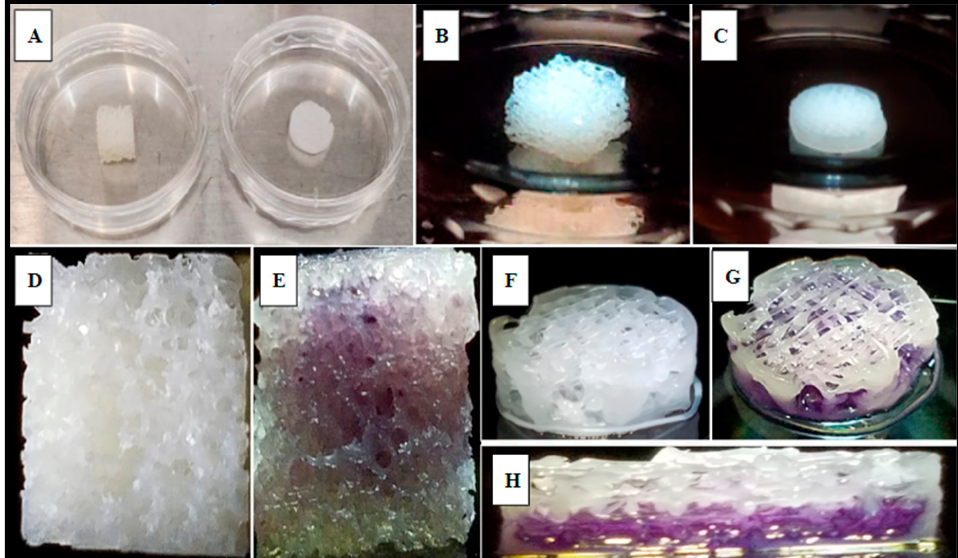
Figure 5. Gross examination of viable SAOS-2 cells integration and localization into scaffold matrices after 5 days via MTT whole scaffold staining. Panel ( A ) displays representative Allowash ® ( left ) and PCL scaffold ( right ) before SAOS-2 seeding and culture. Panels ( B , C ) show seeded scaffolds in culture. Panels ( D , F ) display seeded scaffolds before MTT whole scaffold immersion. Panels ( E , G , H ) display seeded scaffolds following whole scaffold MTT immersion for 1 h. Formazan crystal formation (purple) can be seen within the scaffold matrices marking the location of viable cell populations. Panel ( H ) shows a full-thickness cross-section of the PCL scaffold with uniform viable cell distribution seen in the basal levels of the scaffold